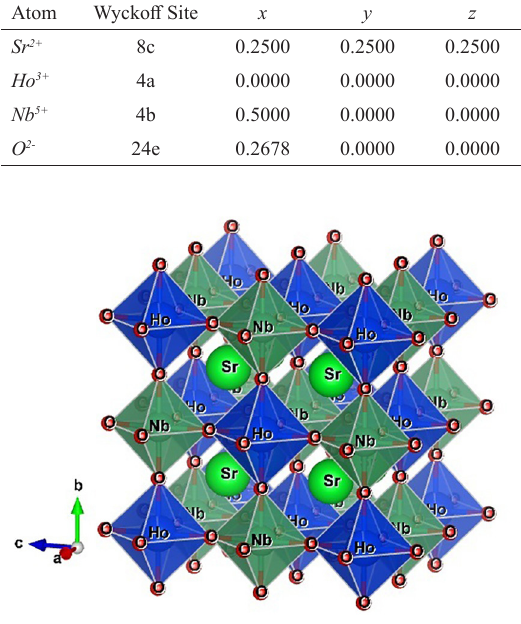
Figure 2: Crystalline structure of the Sr perovskite.